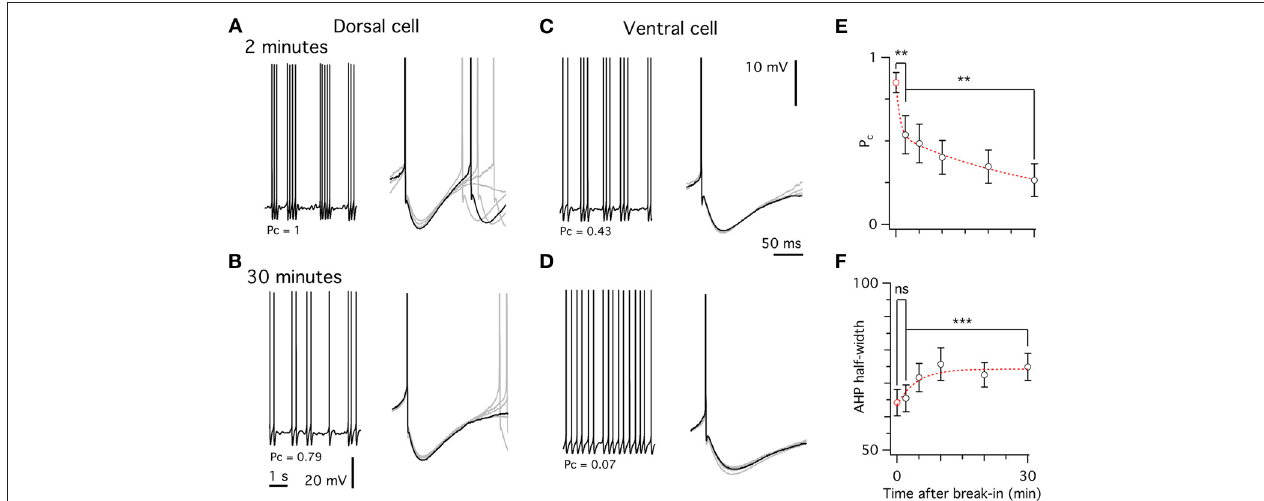
FIGURE 6 | Washout of spiking properties during whole-cell recording. (A,C) Spiking pattern (left) and after-hyperpolarization (right) in a dorsal (A) and ventral (C) stellate cell approximately 2min after break in. (B,D) Spiking pattern and after-hyperpolarization from the same cells as in A,C , 30min after break-in. (E) Decrease of the probability of spikes occurring in a cluster ( Pc )